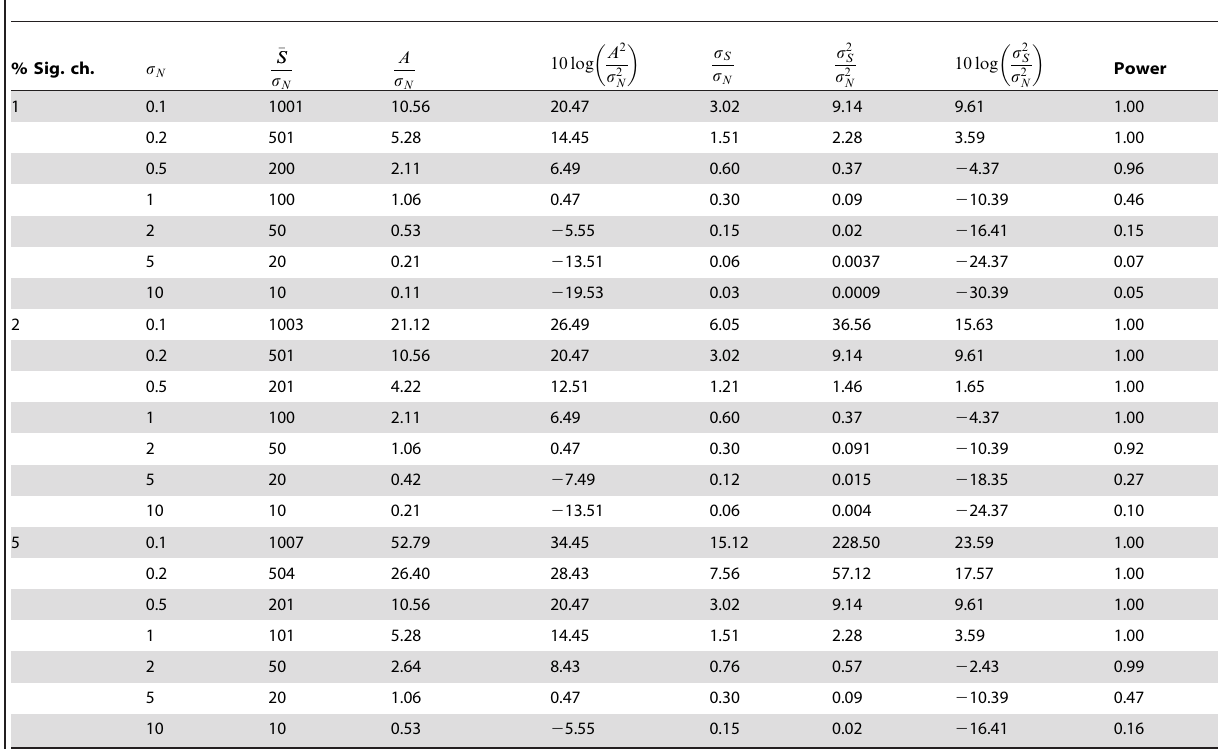
Table 3. Reference table for the different SNR/CNR definitions based on a contrast.